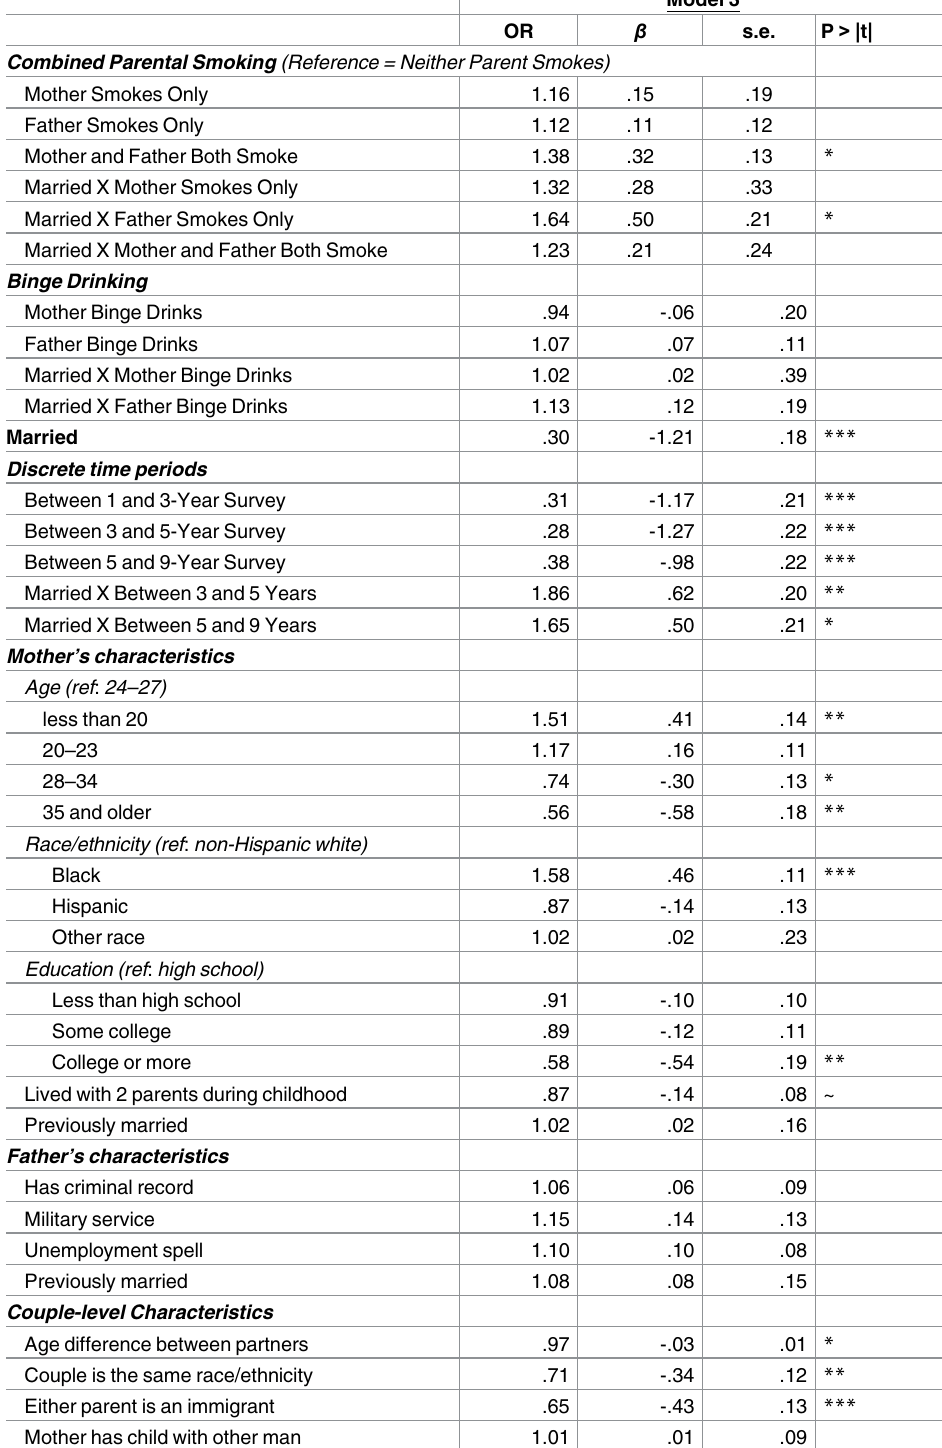
Table 3. Results from discrete time hazard models predicting union dissolution by parental health behaviors, with covariatecontrols (OR = odds ratio, β = coefficient, s.e. = standard